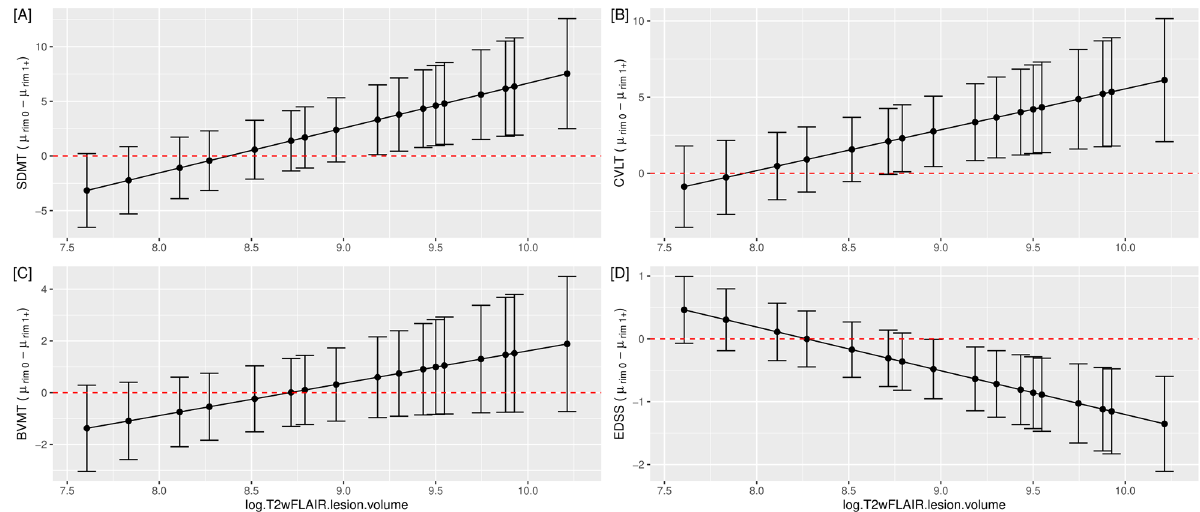
Figure 3. Association of rim+ lesions with disability measures after accounting for clinical and imaging covariates. Patients with both higher total lesion volume on FLAIR and at least one rim+ lesion performed worse on SDMT ( A ), CVLT-II ( B ), and EDSS ( D ) as demonstrated by 95% confidence intervals of the difference of mean disability scores between patients with zero rim+ lesions minus patients with at least one rim+ lesion. The 95% confidence intervals of the means are model-based estimates. The final model included current treatment duration, age, gender, total lesion volume on FLAIR, and the number of rim+ lesions (statistically significant covariates). Performance on BVMT-R ( C ) did not reach clinical significance in the regression model approach and obtained the corresponding multivariate analysis of variance (MANOVA) and subsequent Analysis of Variance (ANOVA) tables for each clinical score. Table 2 summarizes the p-values obtained from the MANOVA and ANOVA tables. We aimed to investigate the effect of possible interactions between the number of rim+ lesions (0 versus at least 1) and other patient-level covariates on disability scores. The only statistically significant interaction was between rim+ lesions and total lesion volume on FLAIR imaging on disability outcome measures (p = 0.006), but each of the variables was also significant (number of rim+ lesions, p = 0.010 and log-TLV, p < 0.001). Other statistically significant patient- level covariates were current treatment duration, age, and gender with p-values of 0.012, < 0.001, and 0.038, respectively. Individual analysis of variance tables for each score confirmed that the interaction effect between (cid:31) β log-TLV and number of rim+ lesions (0 versus at least 1) was statistically significant for SDMT ( = − 4.11, burden increases, patients with at least one rim+ lesion on QSM have, on average, lower SDMT and CVLT-II mean scores. As TLV increases, EDSS mean scores for patients with at least one rim+ lesions are higher than for patients without rim+ lesions. There was no significant difference in performance found between groups for BVMT-R. Figure 3 displays a graphical representation of model-based cognitive and EDSS mean difference